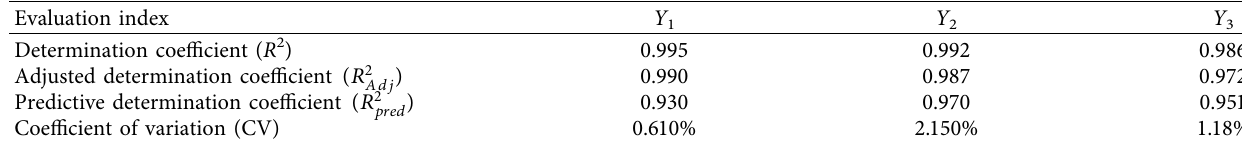
Table 7: Model correlation evaluation.